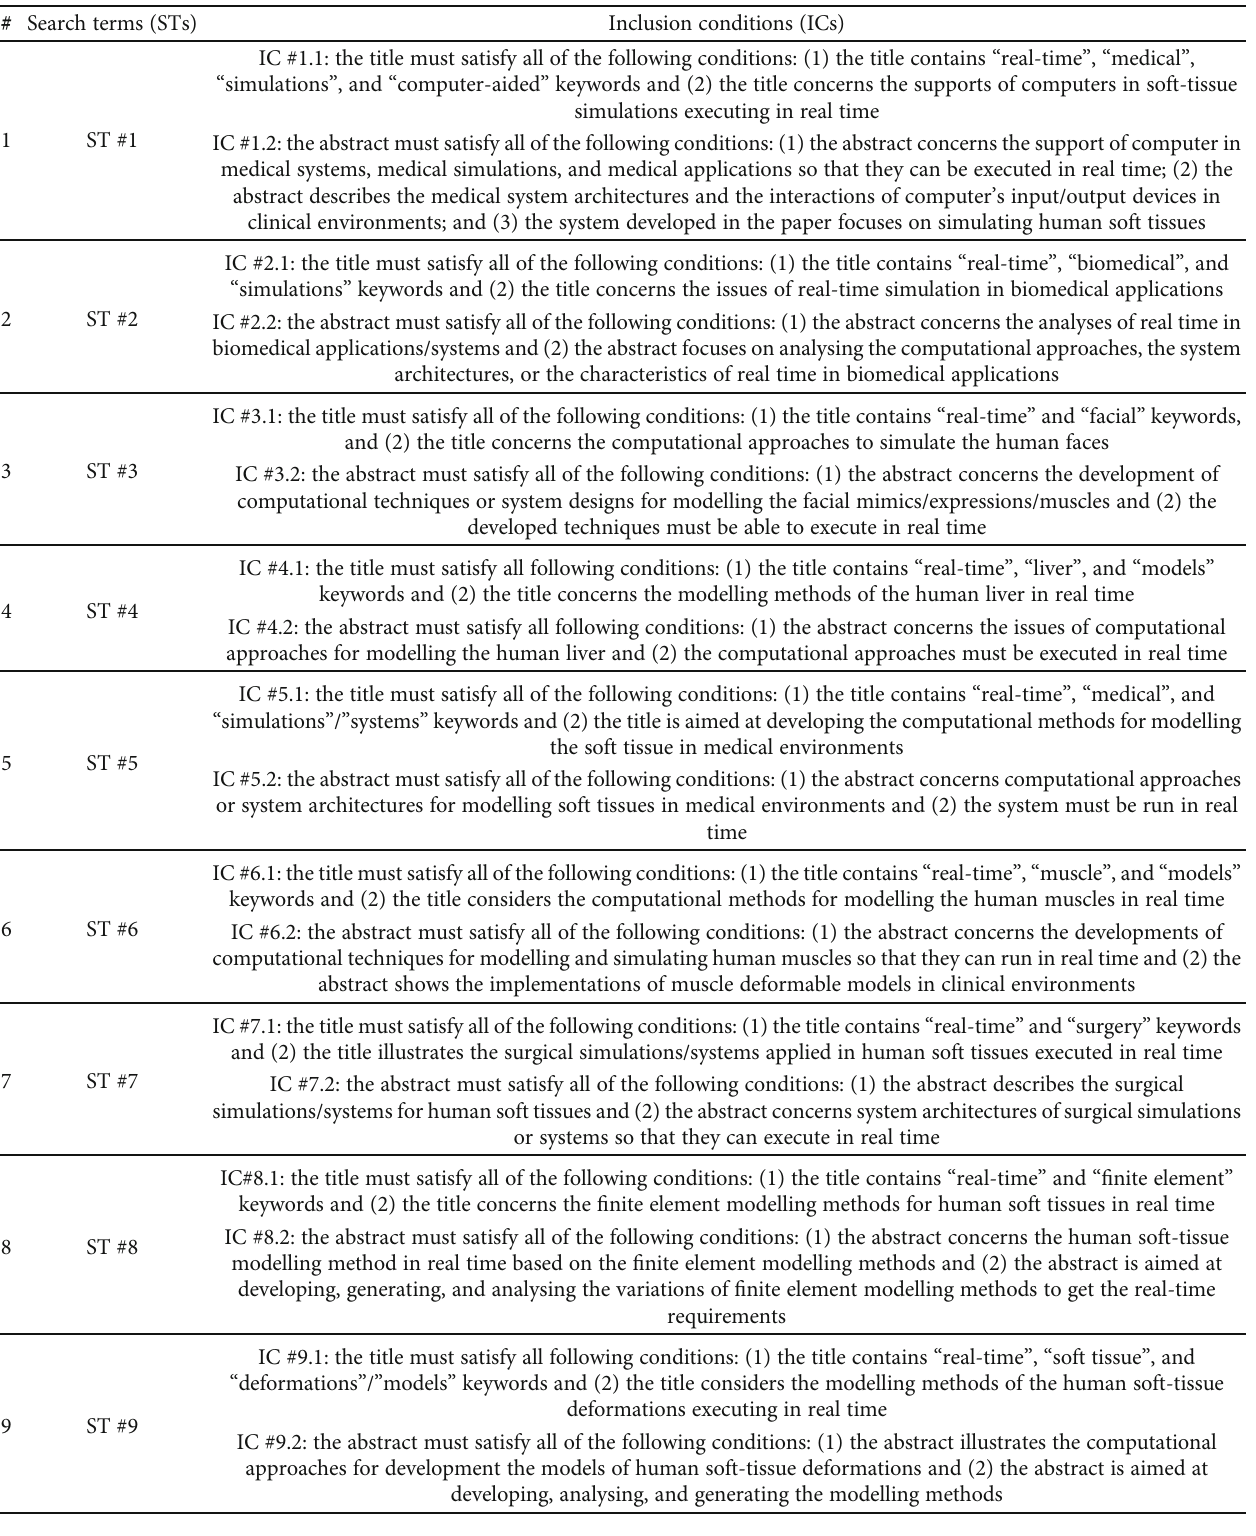
Table 3: The inclusion criteria for each search